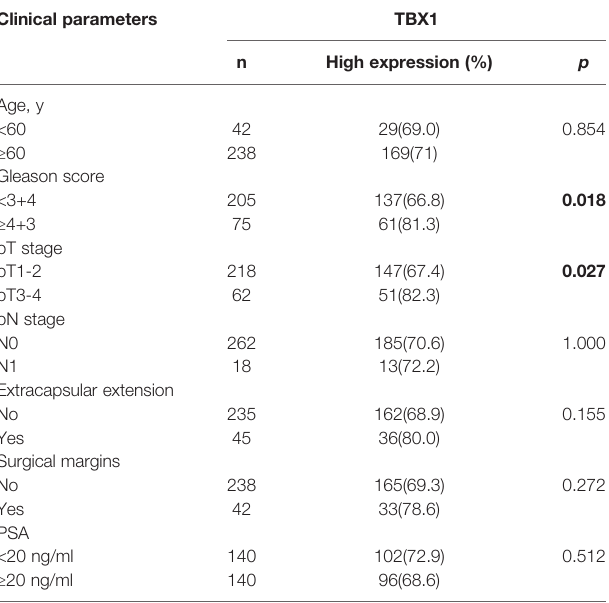
TABLE 1 | Correlation of TBX1 expression with clinicopathologic parameters in 280 PCa